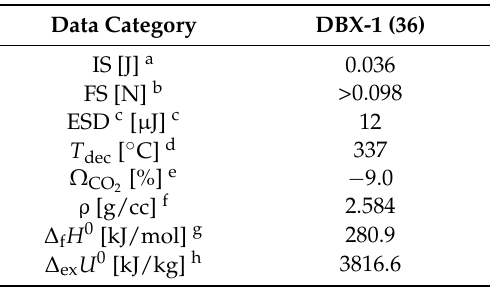
Table 5. Performance and sensitivities of DBX-1 (36).